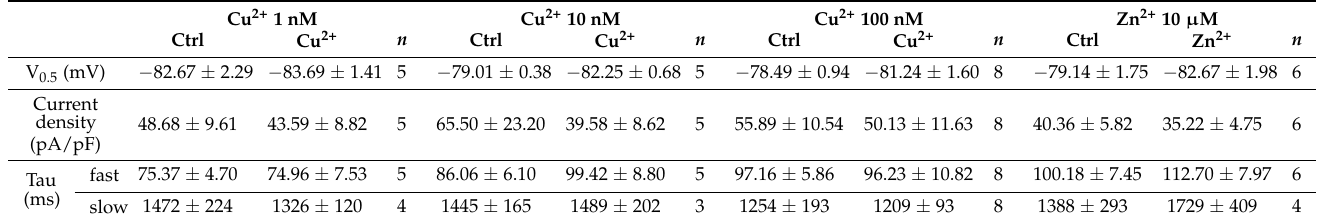
Figure 5. The effects of trace metals on I h current recorded in HEK293 cells expressing mHCN2 channels. ( A ) Exemplary traces of I h current recorded in HEK293 cells in control condition (black) and in the presence of 1 nM copper (blue). For clarity, only the hyperpolarizing step from − 40 mV to − 130 mV is shown. ( B ) The mean steady-state activation curve for control and copper recordings after plotting normalized tail current amplitudes against the step potential and fitting them to a Boltzmann function. ( C – F ) The bar graphs comparing the HCN2 channel V 0.5 ( C ), I h current density ( D ), fast ( E ) and slow ( F ) component of HCN channel activation under control and experimental conditions (as indicated by color-coding). Table 3. The effects of trace metals on I h current in HEK293 cells. Data are given as mean ± SEM. The control measurement and corresponding substance effect were recorded from the same